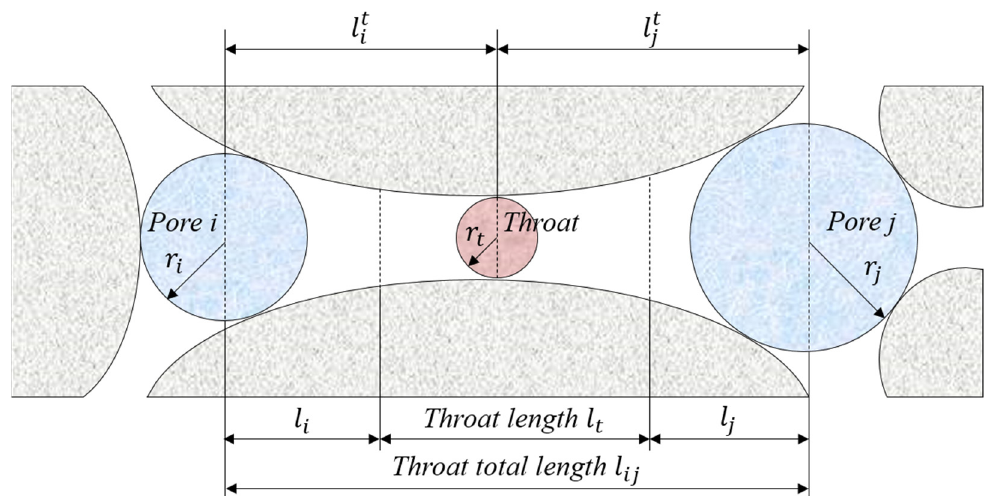
Figure 10. Schematic of the length definition for pores and throats reproduced from [33], with permission from American Physical Society, 2022.